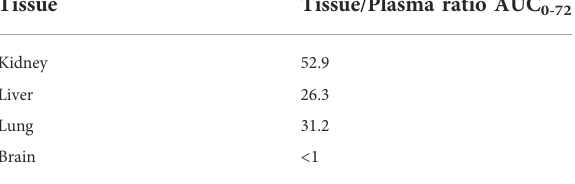
TABLE 4 Tissue Distribution of SAR441566 in rat (80 mg/kg PO).